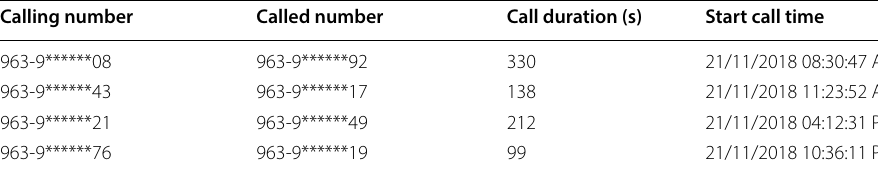
Table 2 Sample of detailed data